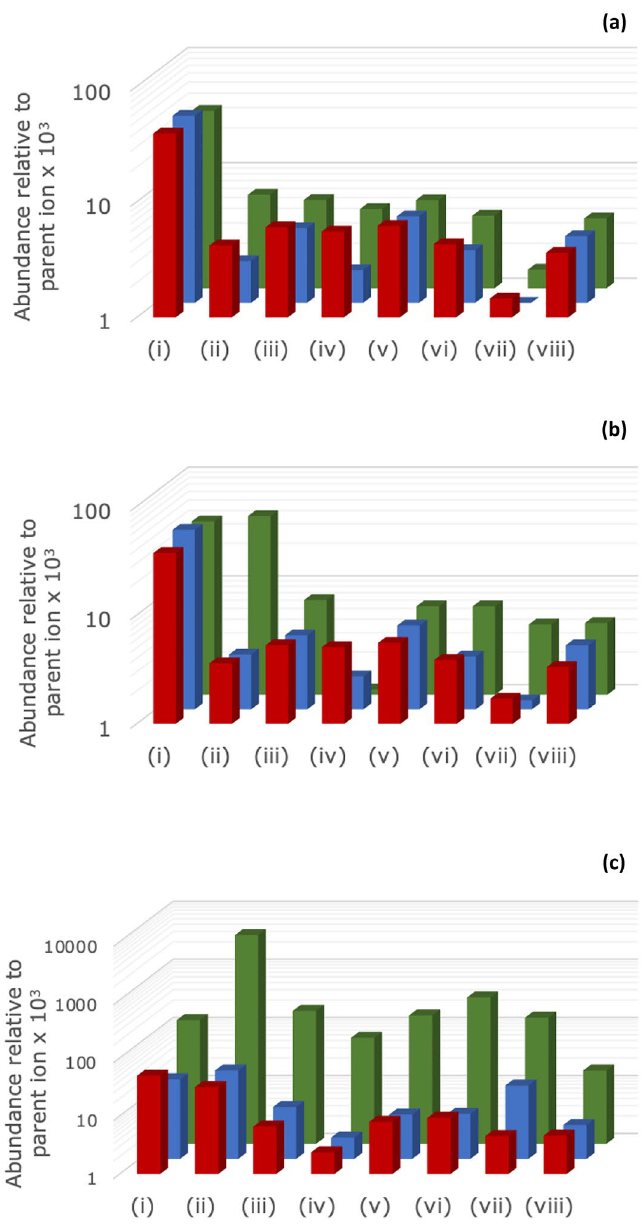
Figure 4. Relative abundance of selected ions in the ToF–SIMS analysis of the (a) pristine ionic liquid, (b) ionic liquid sample heated for ca . 10 s, and (c) ionic liquid sample heated for ca . 60 s. The colours correspond to the ionic liquid: PBOB (green), PBMB (blue) and PBScB (red). The columns represent (i) C 26 H 56 P + , (ii) C 26 H 56 PO + , (iii)